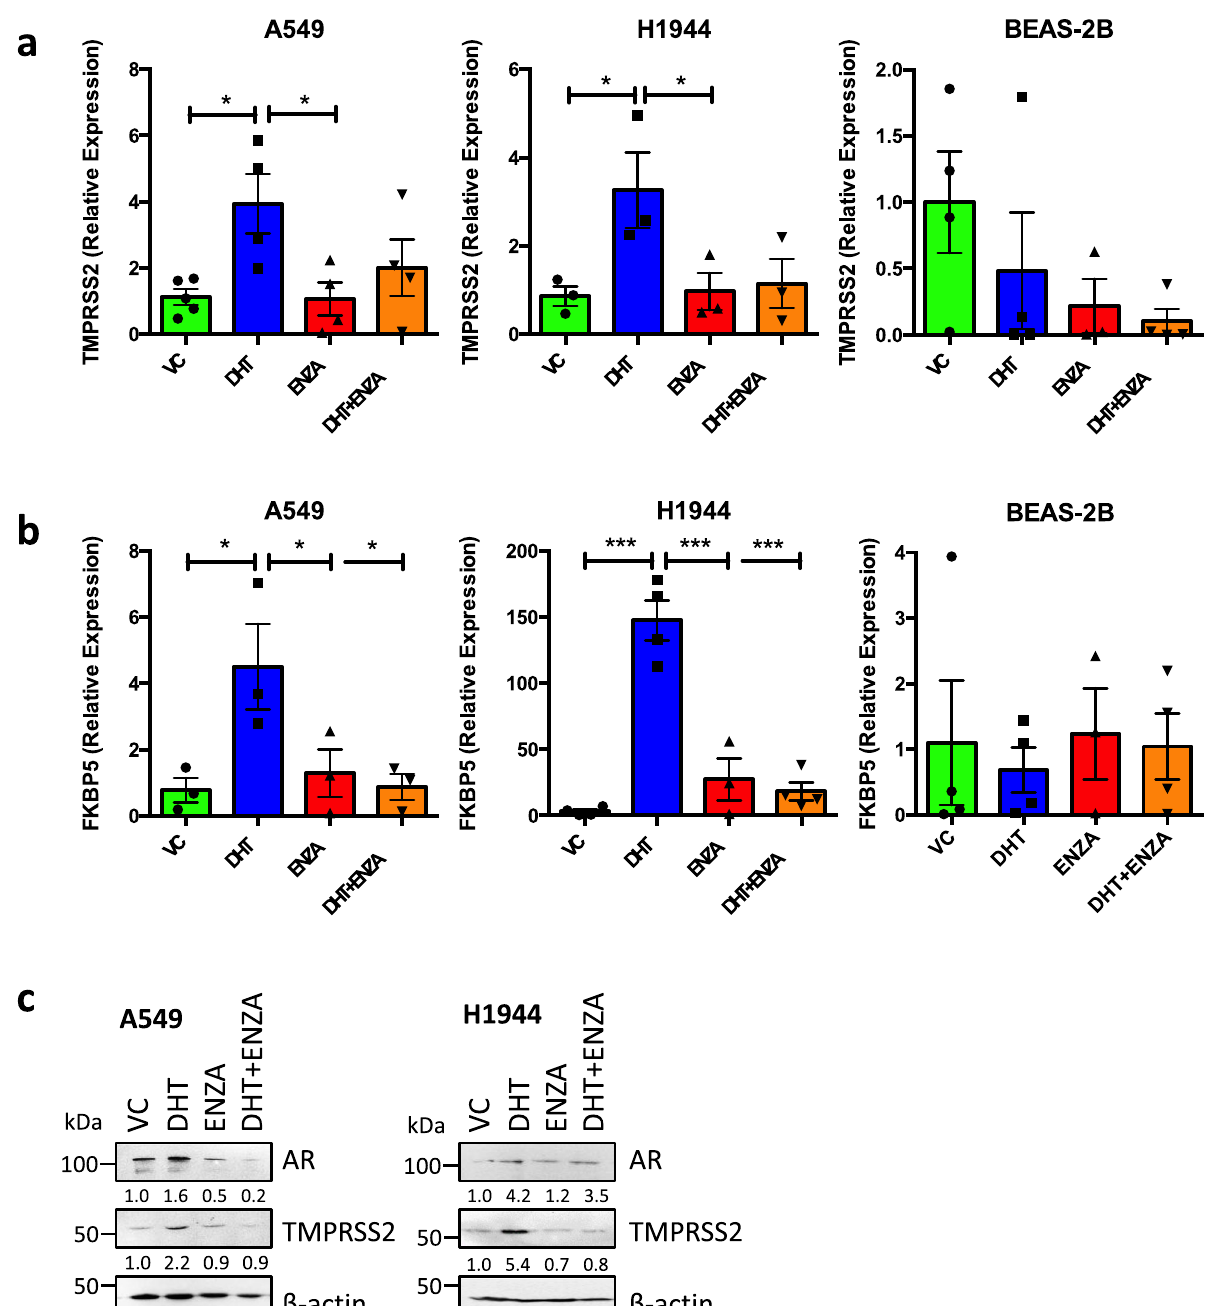
Fig. 4 TMPRSS2 is androgen regulated in lung cell lines. A549, H1944 and BEAS-2B were incubated in hormone-depleted media for 72 h and treated with ±10 nM dihydrotestosterone (DHT) ± 10 μ M enzalutamide (ENZA) for 24 h. RNA was harvested, reverse transcribed and qPCR performed to quantify a TMPRSS2 and b FKBP5 expression. Mean of at least three independent repeats (±1 SEM). Signi fi cance determined using one-way ANOVA with Dunnett ’ s multiple comparison test. TMPRSS2: A549 Vehicle Control (VC) v DHT p = 0.0190, DHT v ENZA p = 0.0228; H1944 VC v DHT p = 0.0410, DHT v ENZA p = 0.0497. FKBP5: A549 VC v DHT p = 0.0250, DHT v ENZA p = 0.0493, DHT v DHT + ENZA p = 0.0285; H1944 VC v DHT p = 5.7 × 10 – 6 , DHT v ENZA p = 7.1 × 10 – 5 , DHT v DHT + ENZA p = 1.7 × 10 – 5 . c A549 were incubated in hormone-depleted media for 72 h and treated with ±10 nM DHT ± 10 μ M ENZA for 24 h. Cells were lysed and proteins separated using SDS-PAGE. Immunoblotting was performed to visualise AR and TMPRSS2 expression levels and β − actin used as a loading control. Densitometry was performed for AR and TMPRSS2, values normalised to β − actin and made relative to VC. Representative immunoblots blots – A549 n = 3, H1944 n = 2. Source data are provided as a Source Data fi